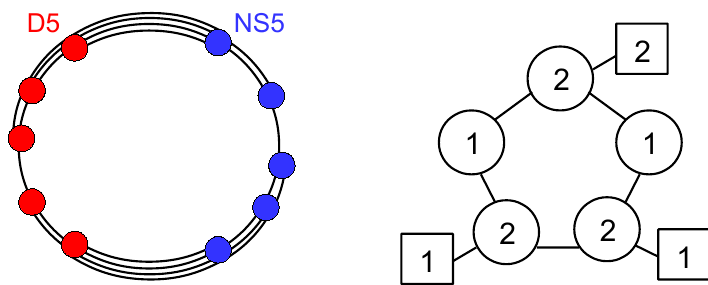
Figure 7 . A brane realization of a circular quiver invariant under the action of S (translation + S-duality). The gauge theory data are read from the linking numbers of the (cid:12)ve-branes: (cid:26) = (2 ; 1 ; (cid:0) 1 ; (cid:0) 1 ; (cid:0) 1), ^ (cid:26) = (1 ; 1 ; 1 ; (cid:0) 1 ; (cid:0) 2). N is the number of D3s stretched between the D5s and NS5s at the top, here N = 4. On the right is the associated good circular